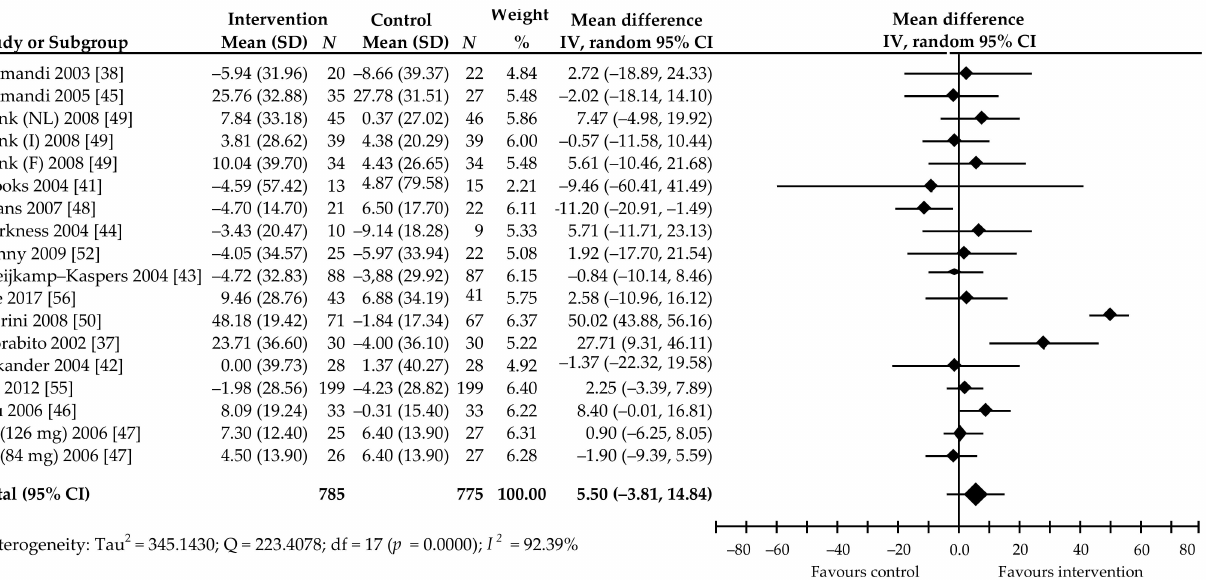
Figure 5. Percentage change in serum BSAP values associated with intake of soy isoflavones compared with placebo. Note: after the author’s name, Isof dose in studies with more than one treatment arm, or abbreviations of the names of the countries where the study was conducted (NL, the Netherlands; I, Italy; F, France), are revealed; data calculated from the random-effects model are presented as weighted mean difference; IV, inverse variance; df, degrees of freedom; the horizontal lines denote the 95% CIs.